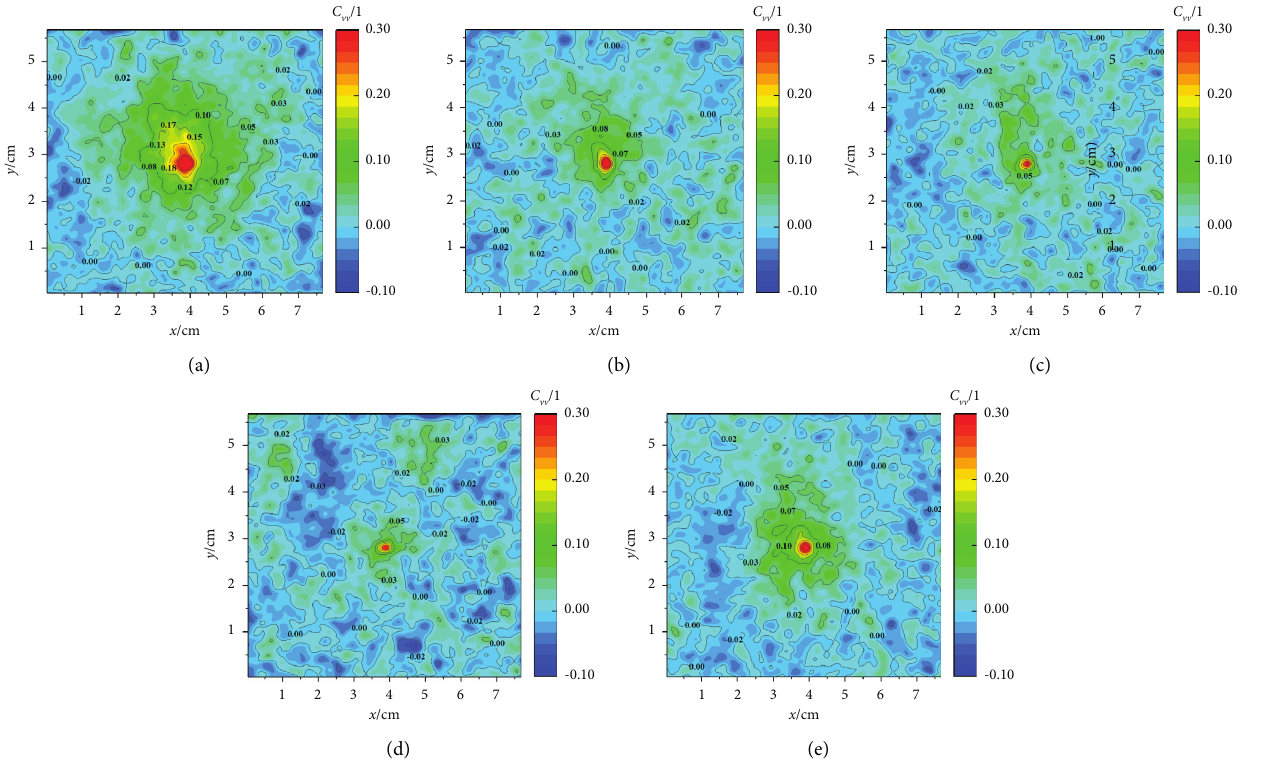
Figure 8: The distribution of C vv in different working conditions. (a) H25-1, (b) H25-1.2, (c) H25-1.5 (D252), (d) D251, and (e)